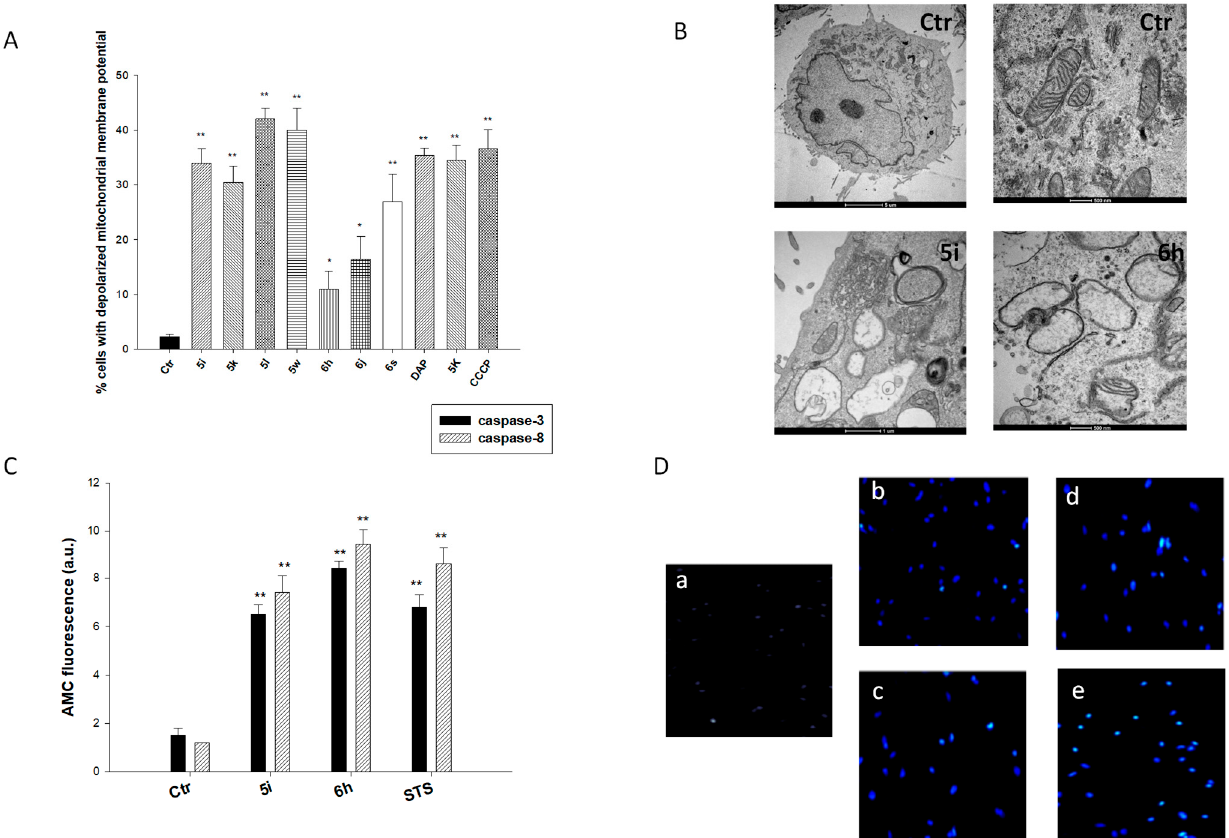
Figure 10. Antimitochondrial effect and induction of caspase-dependent apoptosis. ( A ). Effects of tested compounds on mitochondrial membrane potential. PSN-1 cells were treated with IC 50 concen- trations of tested compounds or CCCP (3 µM). The percentage of cells with hypopolarized mitochon- drial membrane potential was determined by the Mito-ID ® Membrane Potential Kit. Fluorescence in- tensity was estimated at 490 (excitation) and 590 nm (emission). Error bars indicate S.D. * p < 0.05, ** p < 0.01. ( B ). TEM analysis of PSN-1 control cells or cells treated for 24 h with compounds 5i and 6h . ( C ). Effects of tested compounds on caspase activity. PSN-1 cells were incubated for 24 h with tested com- pounds or staurosporine and processed for caspase -3 and -8 activity. Error bars indicate S.D. ** p < 0.01. ( D ). Apoptosis induction. Hoechst staining of PSN-1 cells incubated for 48 h with IC 50 doses of 5i ( b , c ) and 6h ( d , e ). ( a ) represents untreated PSN-1 cells as control.